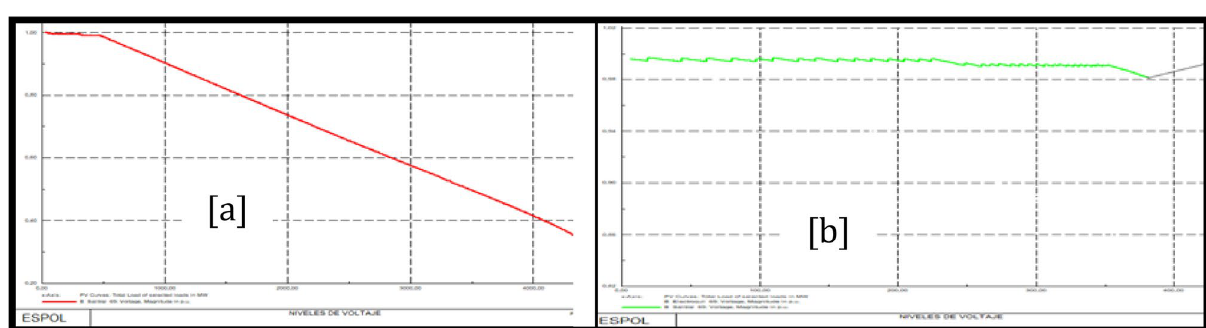
Figure 14. Stability PV before load model ( a ) and PV after load model ( b ) Nueva Electroquil 69 kV bus.